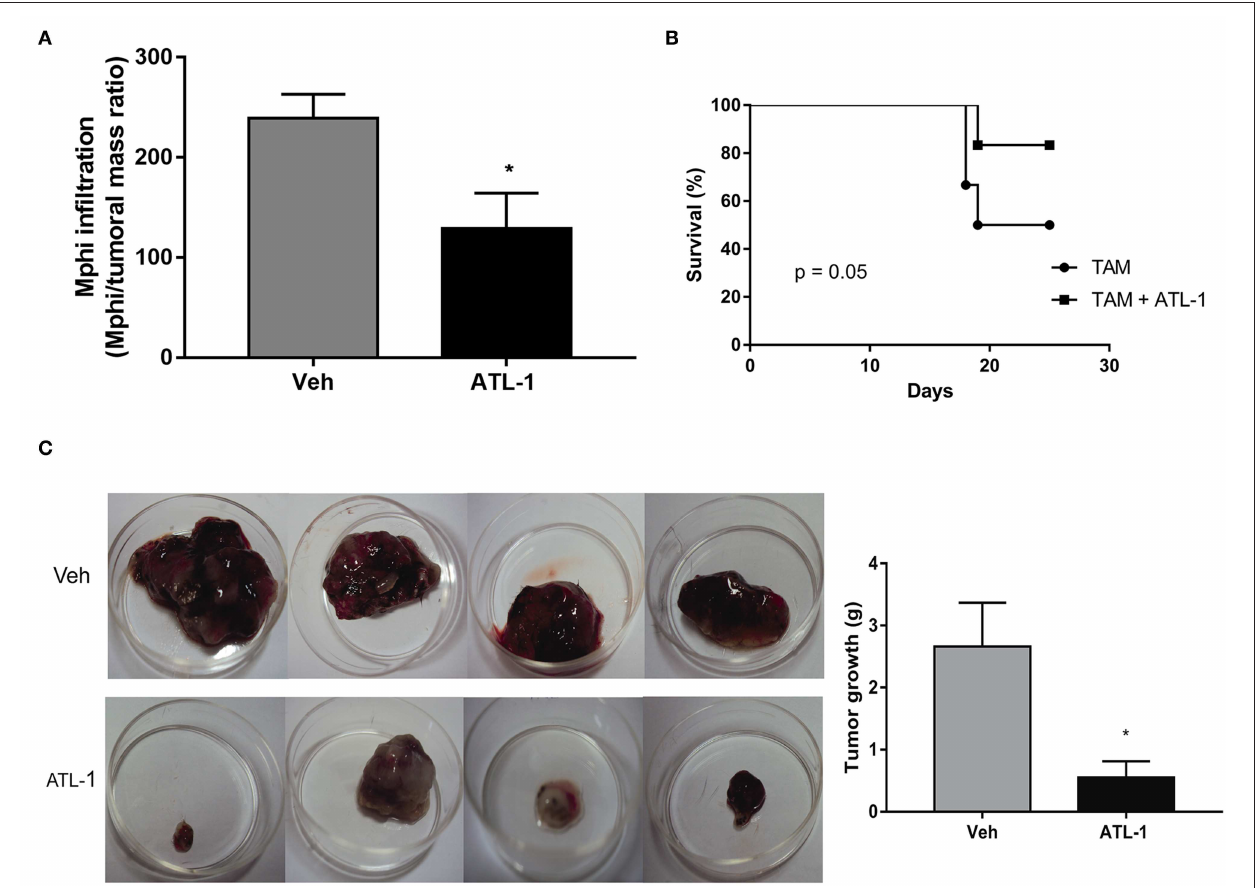
FIGURE 7 | ATL-1 treatment diminished tumor-macrophage infiltration and is able to improve the survival of tumor-bearing mice. C57/BL6 mice were inoculated with B16/F10 tumor cells. After 14 days, ATL-1 (1 µ g/animal) or vehicle (20 µ L ethanol) was administered. On 21st day, some animals were euthanized, and the tumor extracted. Some animals were left in the cage until day 25 for the survival analysis. Mphi (macrophages) were isolated and counted using a Neubauer chamber. (A) The graph represents the number of tumor-infiltrating macrophages ( n = 4–5). Data are expressed as mean ± SEM. * p < 0.05 by unpaired t -test; (B) Survival curve ( n = 6), the survival was recorded according to Kaplan–Meier analysis and analyzed by log-rank (Mantel–Cox) test; (C) Representative pictures and quantitative analysis (weight) of tumors developed in mice treated (lower row) and non-treated (upper row) with ATL-1. Data are expressed as mean ± SEM. * p < 0.05 by unpaired t